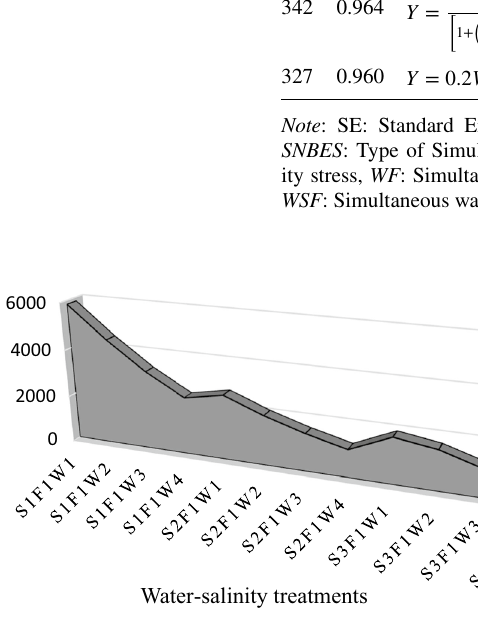
Fig. 7 The slope of crop yield changes in the field (dry leaves) in kil- ograms per hectare under simultaneous water-salinity stress